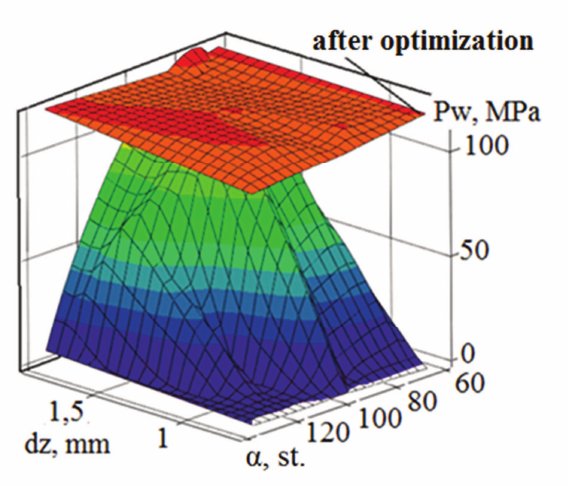
Fig. 5. The relation between injection pressure Pw, dz diameter and the injector valve socket angle (Pz = 100 MPa) For all calculation points in the optimization process, a single-phase injection was set with electric pulse parame- ters (maximum value of current in the solenoid 17.5 A, and during the steady period 10 A, duration of the electric sig- nal 1